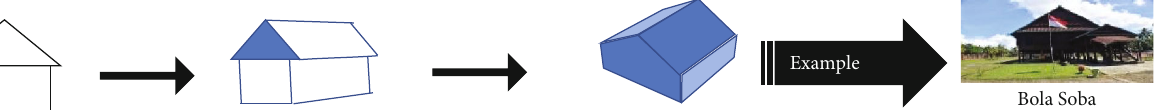
Figure 32: House diagrams of simple house IV.